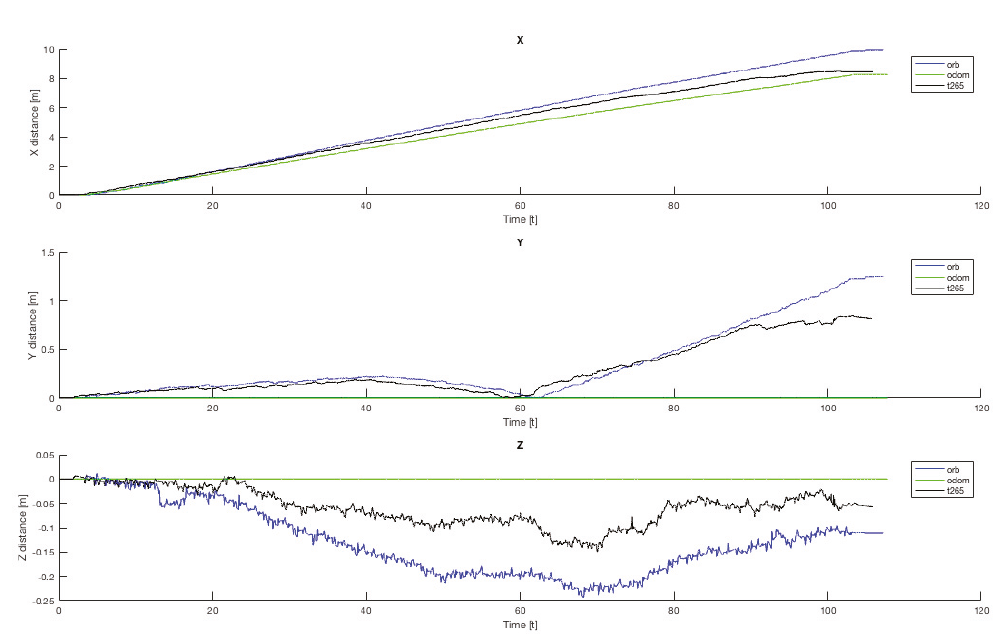
Figure 29. Outdoor test #1.